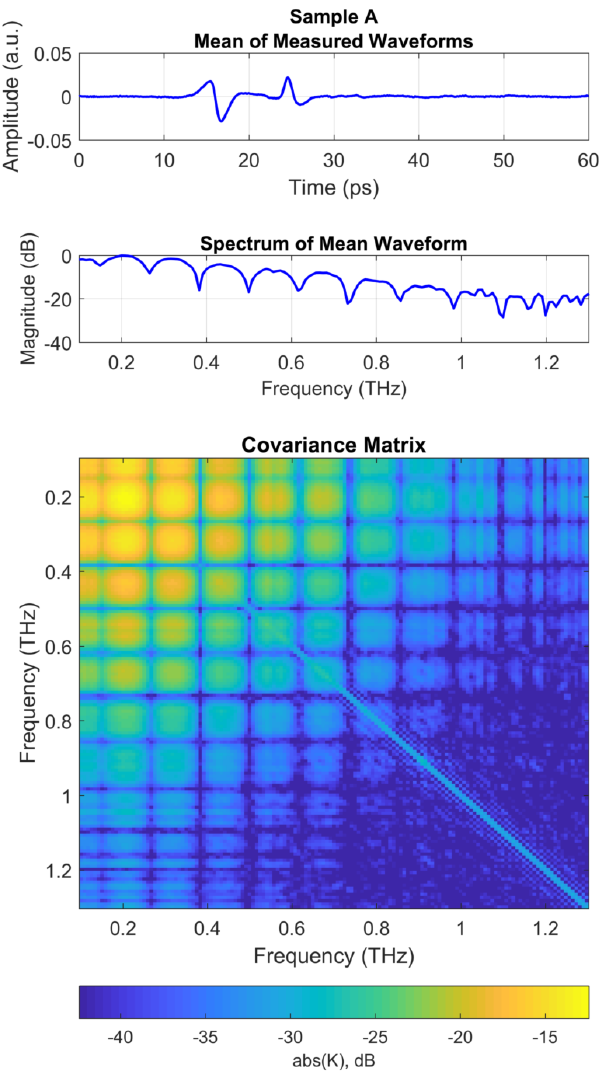
Figure 2. Measured data for Sample A. ( Top ) Mean of measured THz waveforms. Note that reflected THz pulse 1 (illustrated in Figure 1) arrives at approximately 15 ps, and pulses 2 and 3 overlap with one another at approximately 25 ps; ( Middle ) Spectrum of mean waveform in the top panel; ( Bottom ) Covariance matrix computed with Equation (7) using the spectrum of each 300 measured